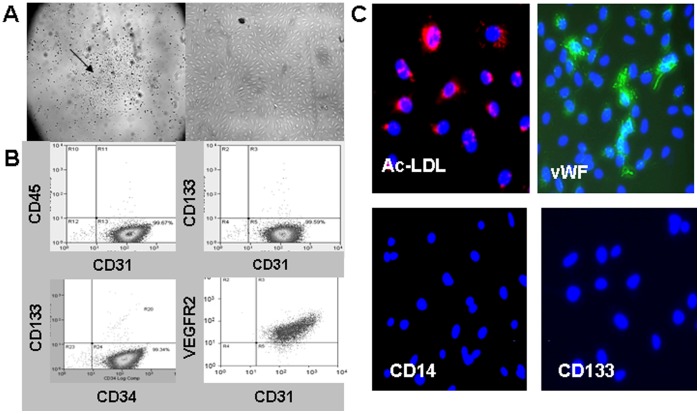
Characterization of Endothelial Colony-Forming Cells (ECFCs).
A) Typical cell morphology after at least 9 days of culture, 10x magnification (left) and cell morphology after passaging reveals typical cobble stone appearance of a colony with rapid proliferation (see arrow), and 40x magnification (right). B) ECFC cells from a typical colony were analyzed by flow cytometry and express CD34 and CD31 surface markers and are negative for CD133 and CD45. C) Immunohistochemistry reveals that ECFC cells can take up Ac-LDL and express vWF but not CD14 and CD133.